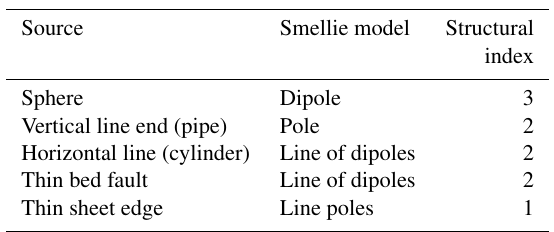
Table 1. Structural index for magnetic sources of different geome- tries. Source Smellie model Structural